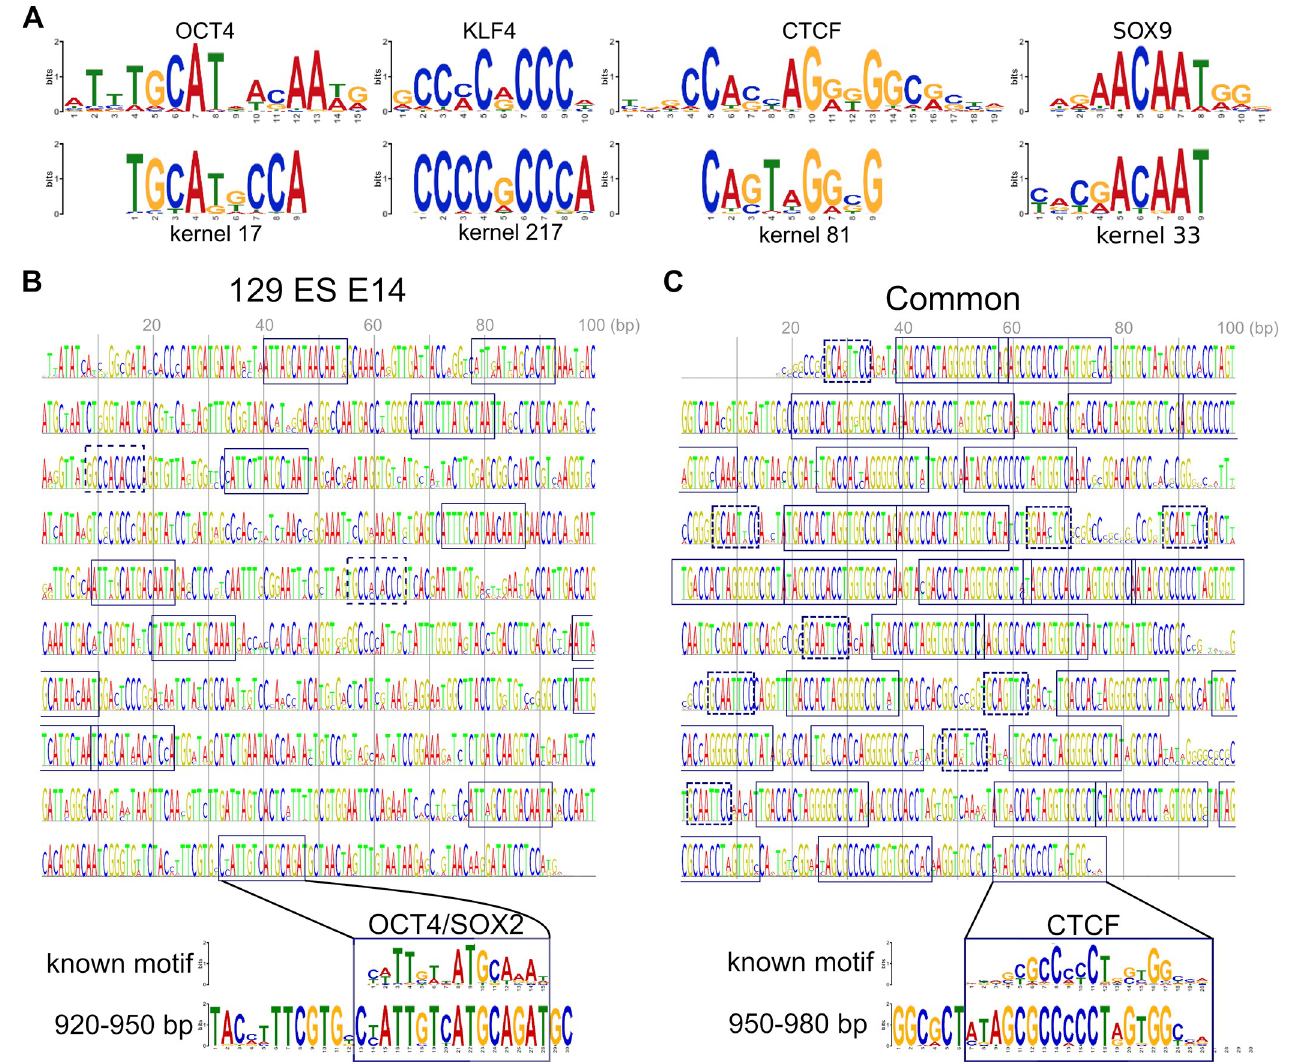
Fig 4. Visualization of trained kernels and results of the activation maximization method. (A) Examples of known motifs (top) that match with kernels. (B, C) Sequences trained to activate the 129 ES E14–specific neuron in the last layer (B) and all neurons in the last layer (C), respectively. Boxes in the left panel, OCT4/SOX2 binding motifs; dashed boxes in the left panel, KLF4 binding motifs; boxes in the right panel, CTCF binding motifs; dashed boxes, motifs similar to the second part of the alternative longer CTCF motif.